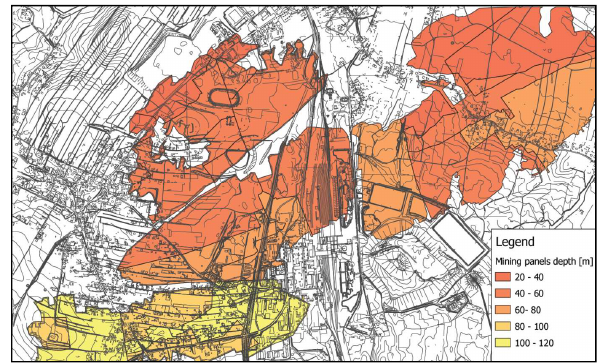
Figure 4. Number of panel edges.